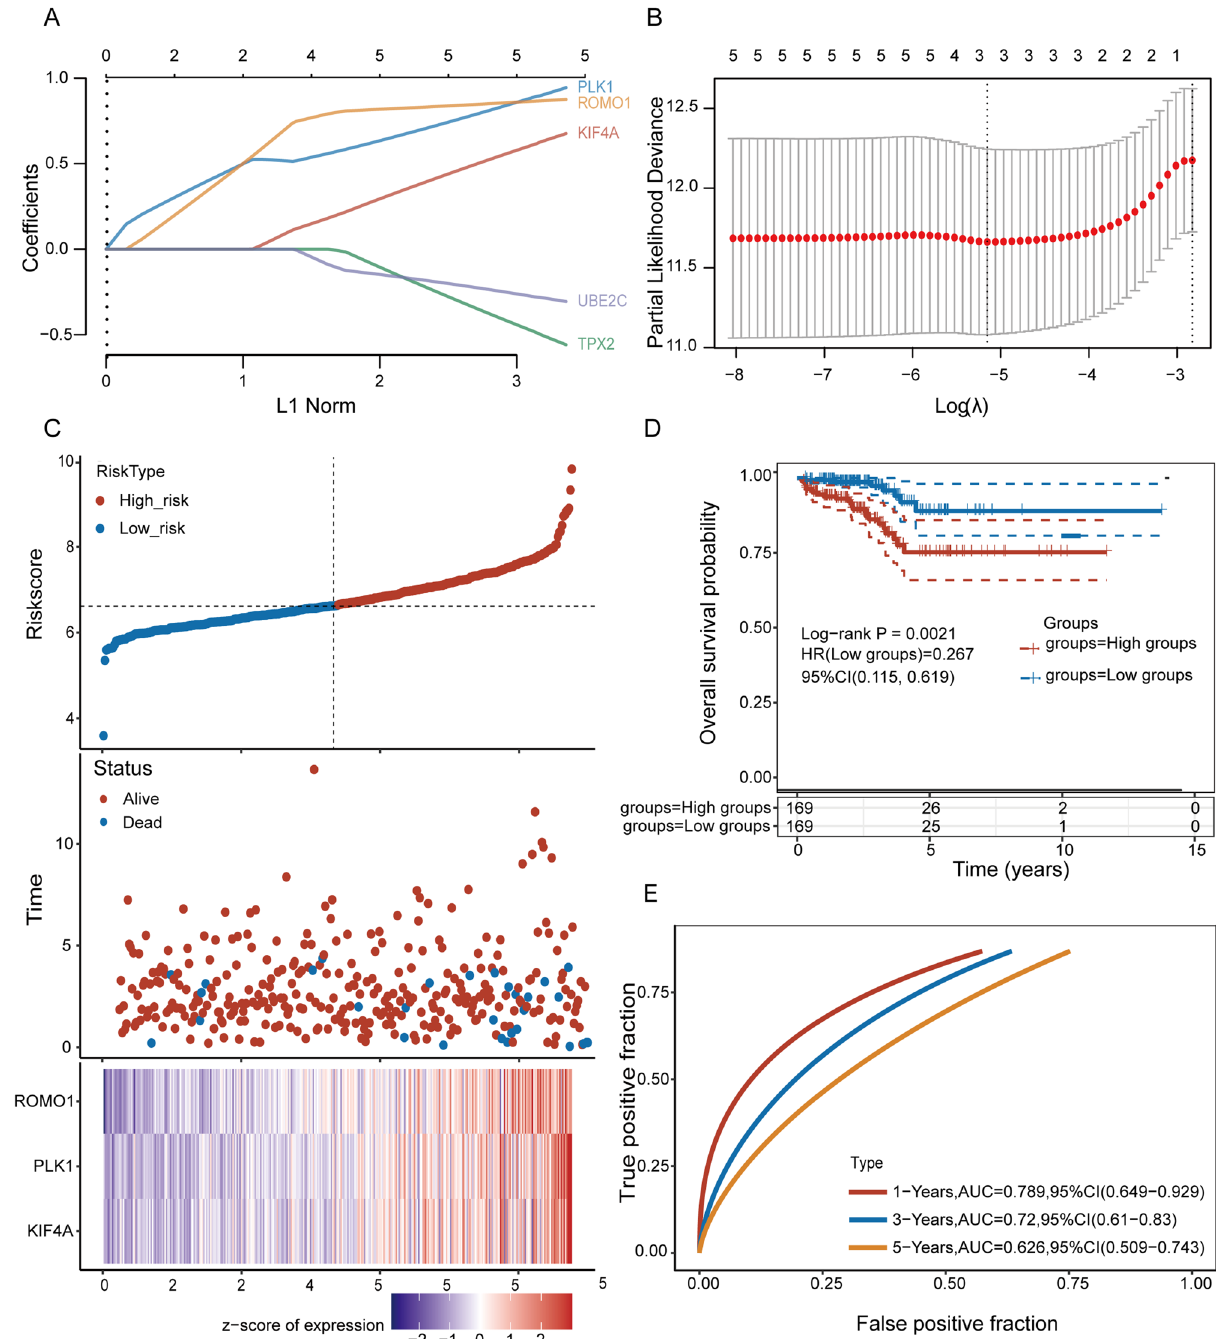
Figure 9. Construction of risk signature prognostic classifier in the TCGA cohort. ( A , B ). Determining the number of key factors through LASSO analysis. ( C ). Distribution of Pca patients based on the risk score in the TCGA database. PCA plot for OCs based on the risk score. The survival status for each patient (low-risk population: on the left side; high-risk population: on the right side). ( D ). Kaplan–Meier curves for the OS of patients in the high- and low-risk groups. ( E ). ROC curves of hub genes for predicting 1/3/5-year survival in the TCGA